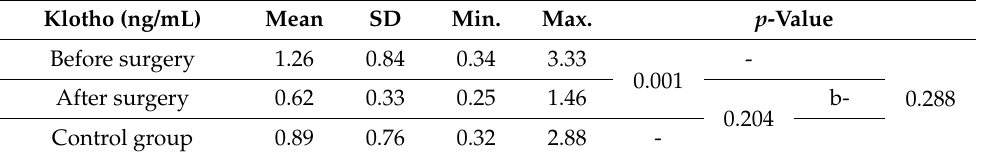
Table 3. Serum concentrations of Klotho protein in study group vs. control group.